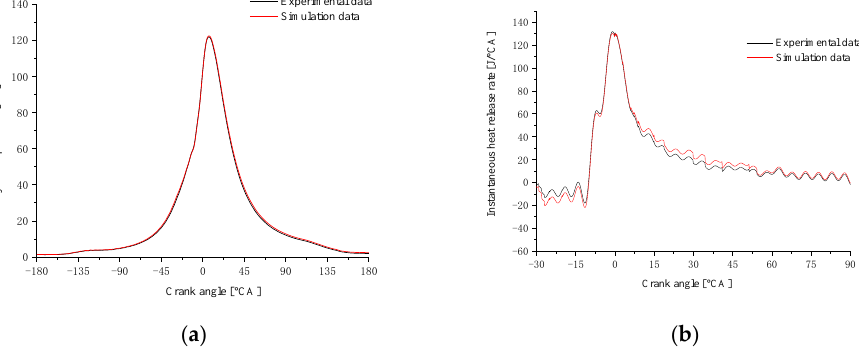
Figure 12. Comparison of in-cylinder pressure and Instantaneous heat release rate between the sim- ulation and experiment. ( a ) Cylinder pressure; ( b ) Instantaneous heat release rate. 3.2. The Effect of Spray Angle on Combustion Characteristics In accordance with the calibration, the parameters of the combustion model are set as shown in Table 9.